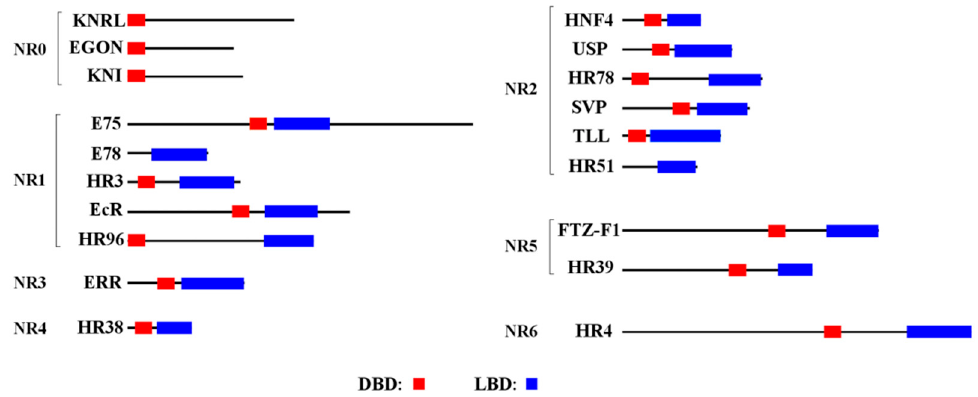
Figure 1. Domain architectures of 21 NR proteins in B. dorsalis . DNA-binding domain (DBD) (red); ligand-binding domain (LBD) (blue). The deduced amino acid sequences were used to predict the domain architectures in SMART (http: // smart.embl-heidelberg.de / ) and NCBI Conserved Domains Search (https: // www.ncbi.nlm.nih.gov / Structure / cdd / wrpsb.cgi). Table 1. List of the NR proteins identified in the B. dorsalis genome and NRs in D. melanogaster. Group B. dorsalis